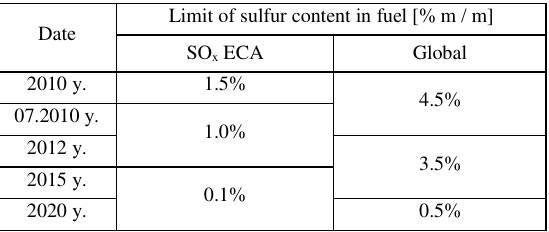
Table 1. Permissible limits of sulfur content in fuel